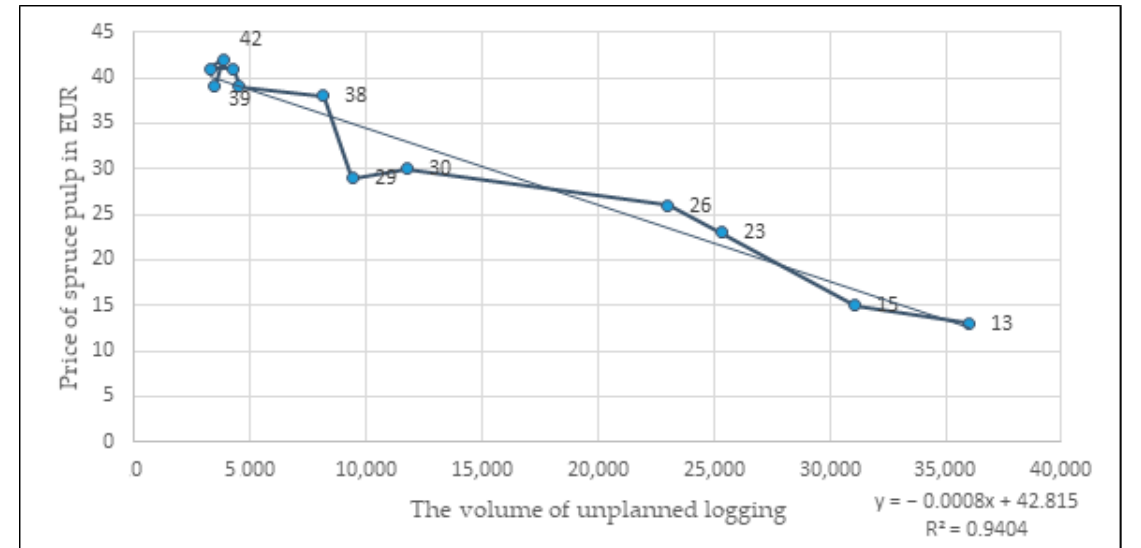
Figure 5. Dependence of the price of spruce pulp on the volume of unplanned logging; Source: Č SU; (Czech Statistical Agency) 2020, Forestry.